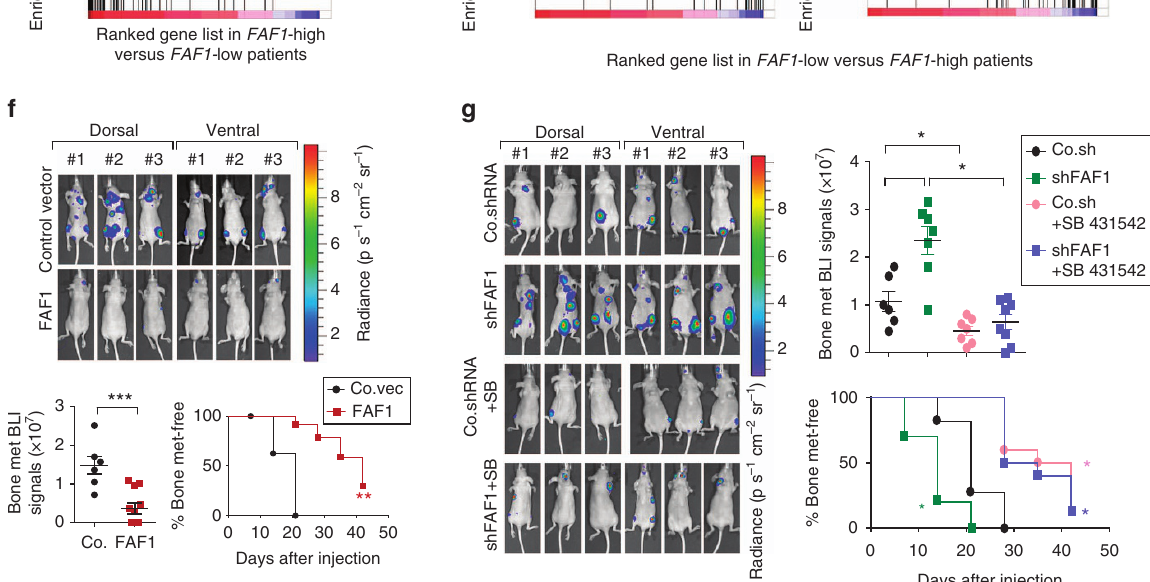
Figure 4 | FAF1 inhibits bone metastasis in transplantable mouse model of metastasis and correlates with good prognosis in breast cancer patients. ( a ) Pre-ranked gene set enrichment analysis (GSEA) in FAF1 -high versus FAF1 -low patients. The consensus signature of the genes correlated with good prognosis (upper panel) or lower invasiveness (lower panel) was enriched in FAF1 -high compared with FAF1 -low patients. ( b ) Immunoblot (IB) of control and MCF10A-RAS cells stably expressing FAF1 or depleted of endogenous FAF1 (shFAF1) and treated with TGF- b (5ngml (cid:2) 1 ) and SB431542 (10 m M) as indicated for 48h. Epithelial-to-mesenchymal transition (EMT) marker proteins were analysed as indicated. ( c ) Heat map of TGF- b target and EMT-related genes in control or MCF10A-RAS cells stably expressing FAF1 or depleted of FAF1 (#1 and #2) and treated with or without TGF- b (1ngml (cid:2) 1 ) for 8h. ( d ) Consensus signature of genes significantly and negatively correlated with breast cancer metastasis are enriched in FAF1 -high versus FAF1 -low patients, as shown by pre-ranked GSEA. ( e ) Consensus signature of genes significantly and positively correlated with breast cancer metastasis (left panel), especially bone metastasis (right panel), are enriched in FAF1 -low versus FAF1 -high patients, as shown by GSEA (right panel). ( f ) Bioluminescent imaging (BLI) of three representative mice from each group at week 6 following injection with control or MDA-MB-231 cells stably expressing FAF1. Both ventral and dorsal images are shown (upper panel). The BLI signal of every mouse (lower left panel) and the percentage of bone metastasis-free mice (lower right panel) in each experimental group were followed over time. ( g ) The BLI of three representative mice from each group at week 6 following injection with control or MDA-MB-231 cells stably depleted of FAF1 and pretreated with or without SB431542 (SB, 10 m M) overnight. Both ventral and dorsal images are shown (left panel). The BLI signal of every mouse (right upper panel) and the percentage of bone metastasis-free mice (right lower panel) in each experimental group are shown over time. Data are presented as the mean ±